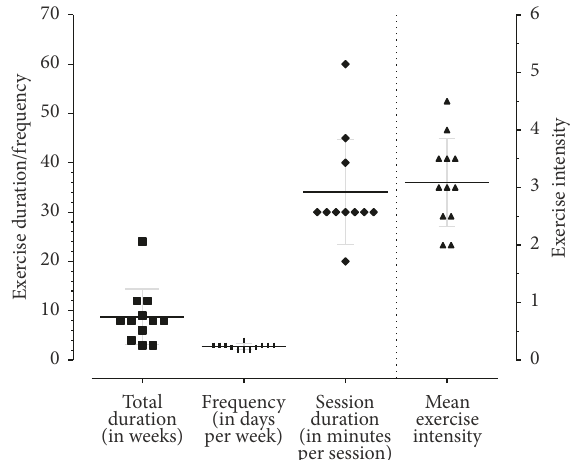
Figure 4: Summary of exercise parameters. 𝑋 -axis: total duration of exercise program (in weeks), frequency of exercise sessions (number of days per week), duration of exercise sessions (in minutes per session), and intensity of exercise sessions in each study included in this review. Left 𝑌 -axis: exercise duration and frequency. Right 𝑌 -axis: exercise intensity (1: very light, 2: light, 3: moderate, 4: hard, 5: very hard, and 6: maximum) (adapted from ACSM’s guidelines for exercise testing and prescription, 9th edition, 2013) [55]. The measures of dispersion (mean and standard deviations) of exercise parameters are indicated by the horizontal lines transecting the data